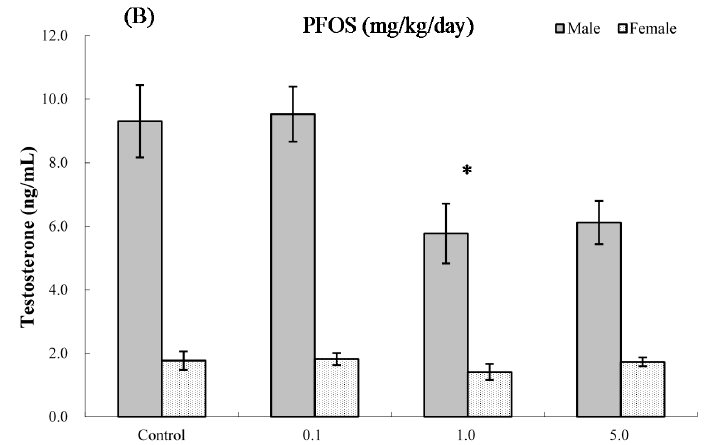
Figure 5. Serum levels of testosterone in C57BL/6 mice exposed in utero to PFOS during GD 1–17. Cells obtained from mice at ( A ) four and ( B ) eight weeks of age. Data shown are the mean ± SEM. * Value significantly different from respective controls ( p ≤ 0.05) by one-way ANOVA test. All PFC data were log-transformed prior to statistical analysis. n = 12 each group.